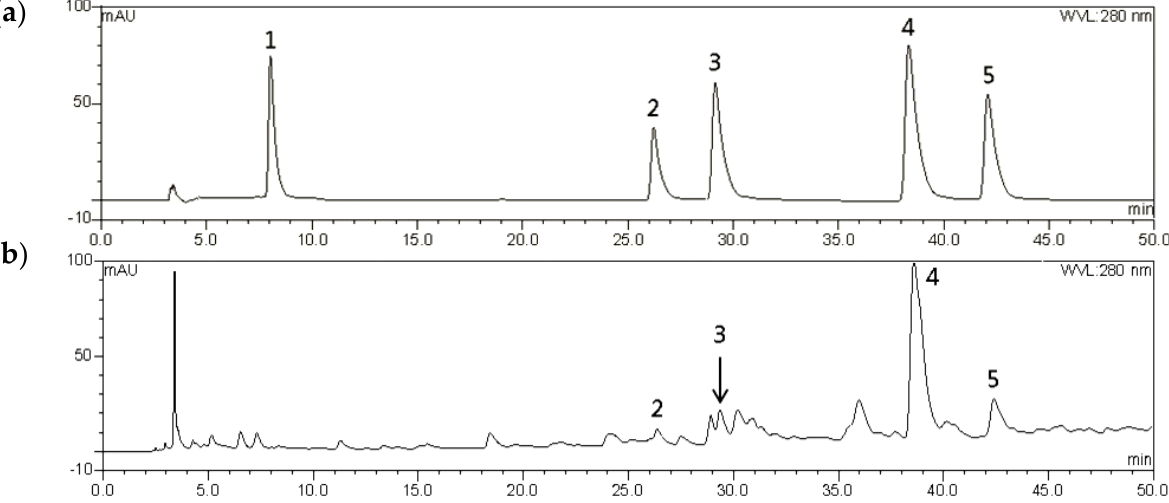
Figure 6. High − performance liquid chromatography (HPLC) chromatographic profiles recorded at 280 nm of ( a ) phenolic compound mixed standards (each 0.1 mg/mL) and ( b ) the ATE-BuOH fraction (10 m(g/mL) (1: gallic acid, 2: chlorogenic acid, 3: caffeic acid, 4: p-coumaric acid, and 5: ferulic acid).